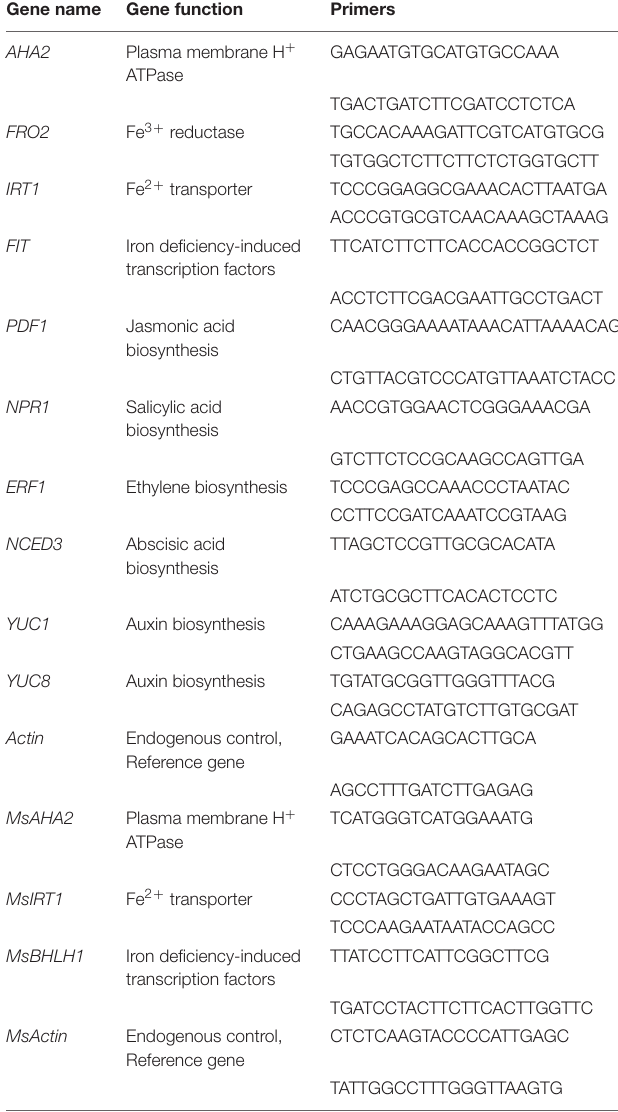
TABLE 1 | Primers used in RT-qPCR